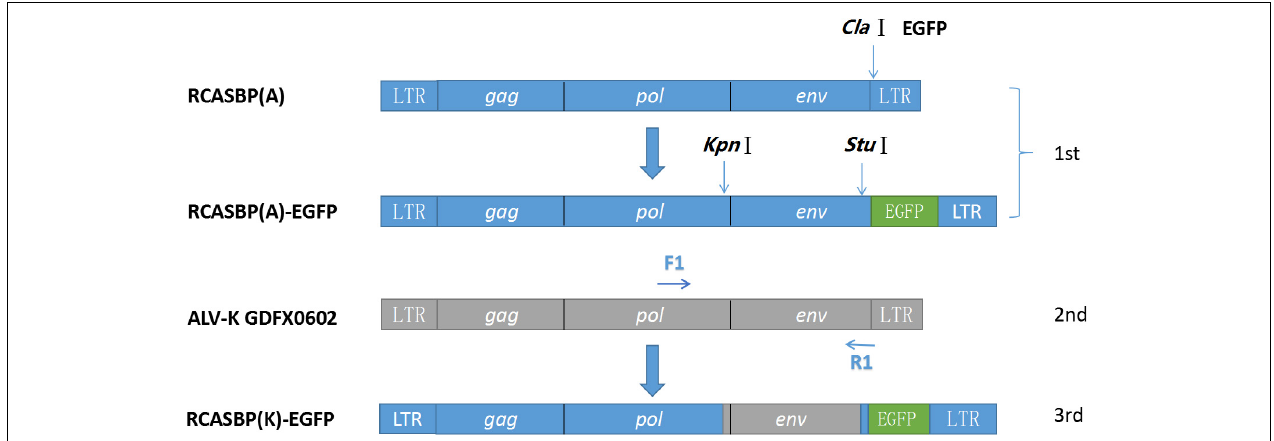
FIGURE 2 | Strategy for constructing replication-competent avian retrovirus vectors containing Bryan polymerase (RCASBP). RCASBP (K)-enhanced green fluorescent protein (EGFP) recombinant virus EGFP was used with EGFP- Cla I-F/R and inserted at ClaI site of vector RCASBP. Primers RCASBP-F/R were used to validate the sequencing of vector RCASBP (A)-EGFP; primers F1 and R1 were used to amplify the Env fragments of the ALV-K GDFX0602 isolate, which was used to replace env of RCASBP (A)-EGFP; and primers RCASBP (K)-F/R were used to validate the sequencing of vector RCASBP (K)-EGFP.